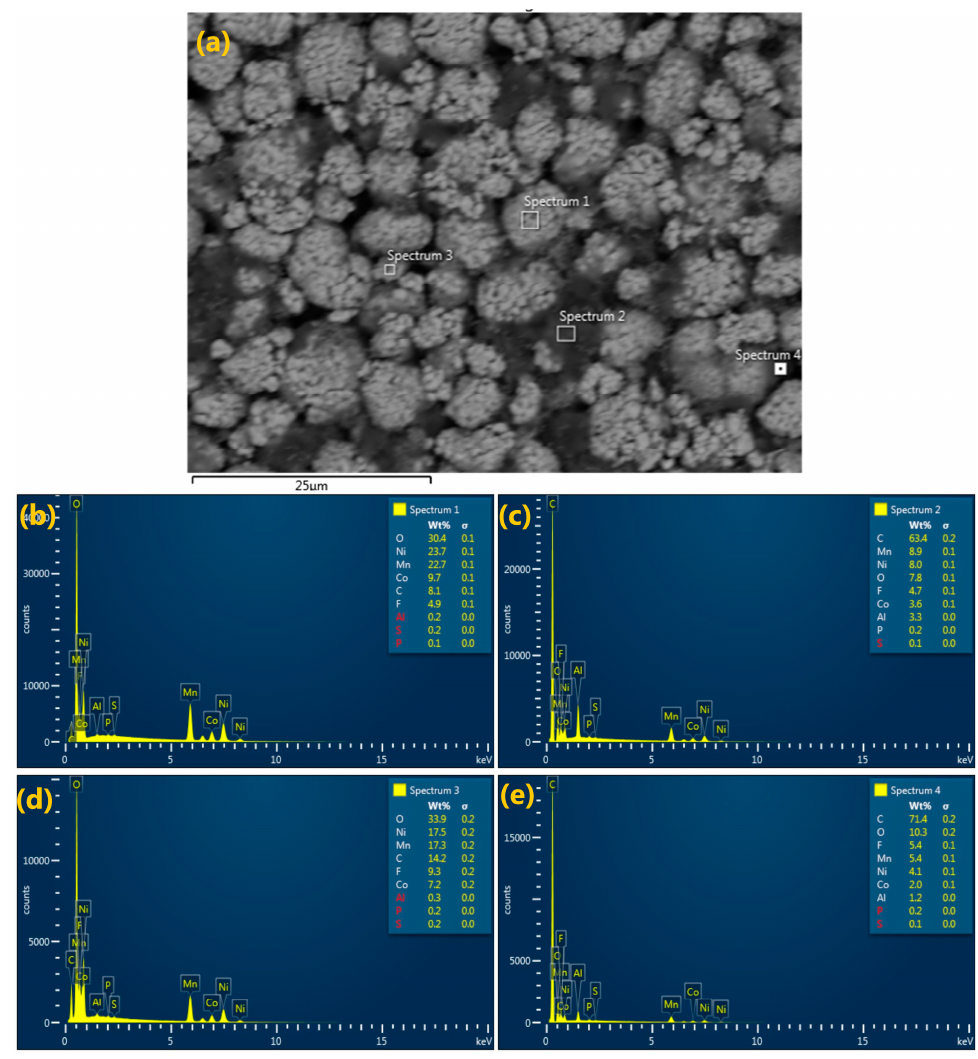
Figure 8. ( a ) EDS analysis of the chemical composition of the harvested cathode at four locations; ( b – e ) the localized volumetric analysis of the spectrum 1, 2, 3 and 4,